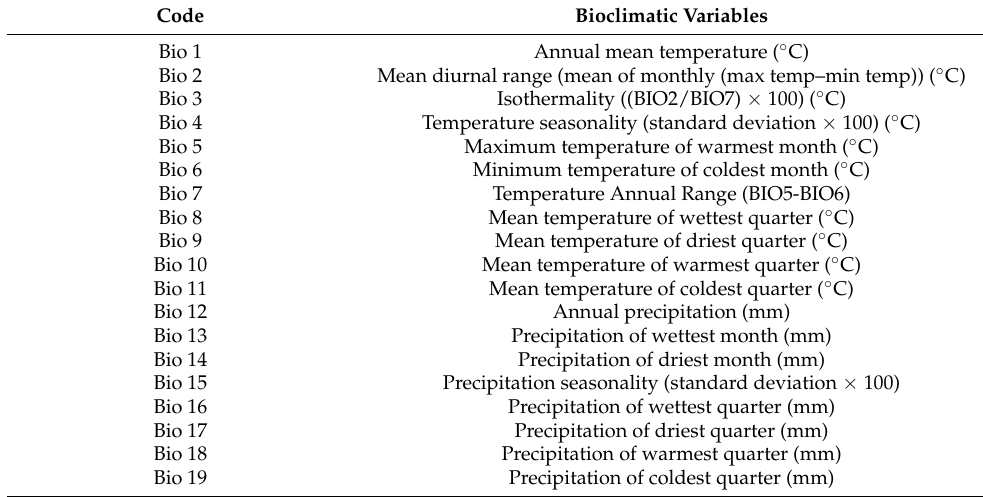
Table 1. Environmental variables considered modeling the potential